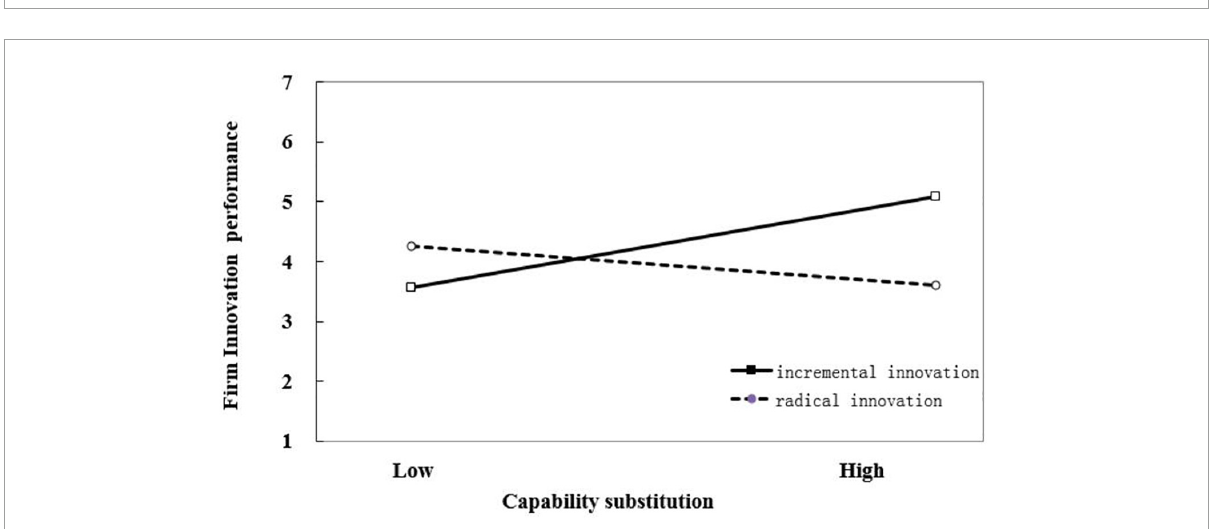
FIGURE3 Moderating effect of innovation magnitude on the relationship between capability substitution and firm innovation performance in the early stage of